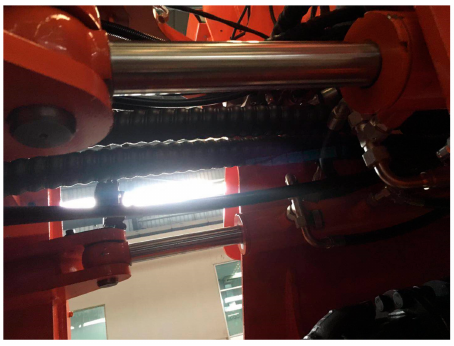
Figure 5. Steering mechanism of a FW50GL loader.